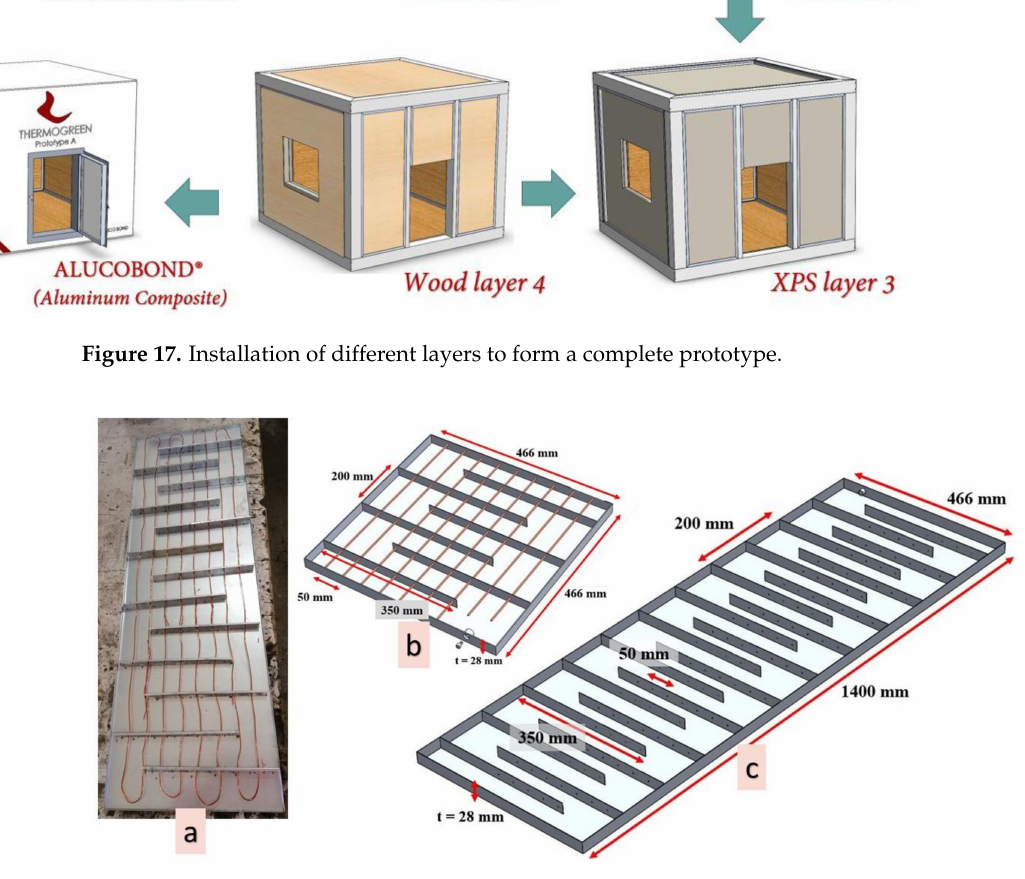
Figure 18. The enhanced plate: ( a ) a real picture, and detailed dimensions of: ( b ) small and ( c ) large